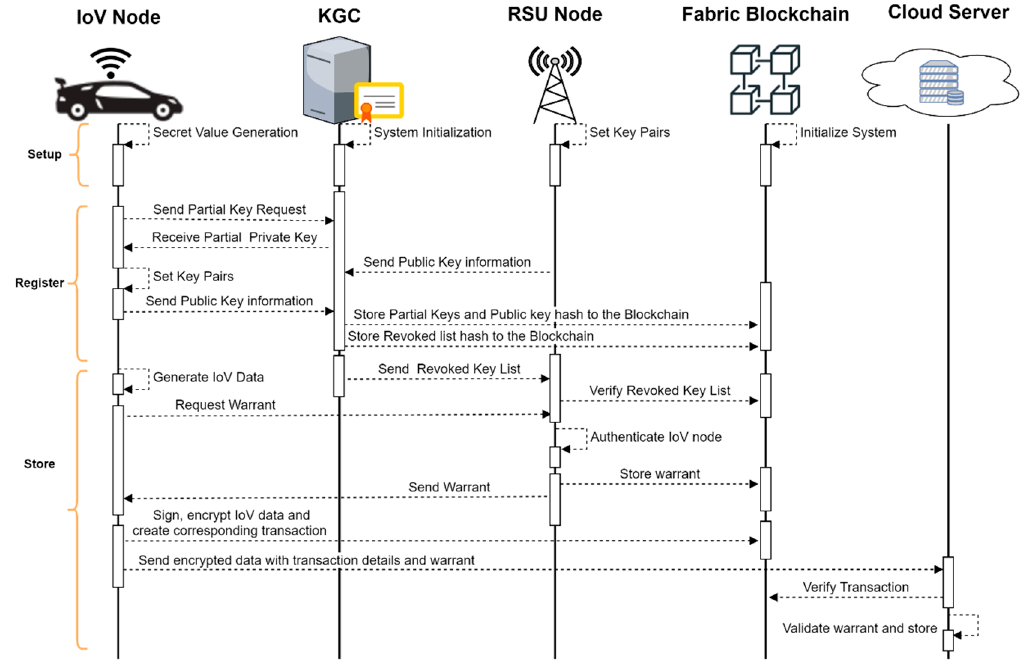
Figure 6. Communication flow between the nodes in the system.